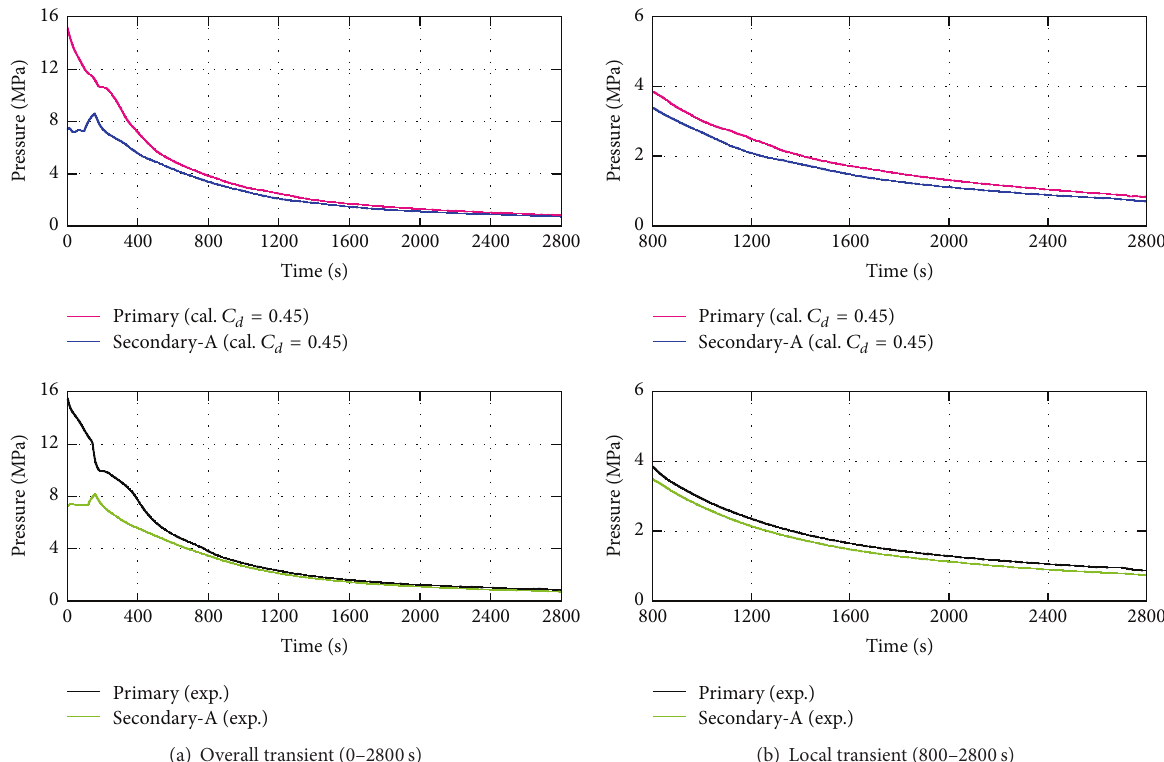
Figure 21: LSTF and RELAP5 results for primary and SG secondary pressures in loop-A in case of no release of dissolved gas.